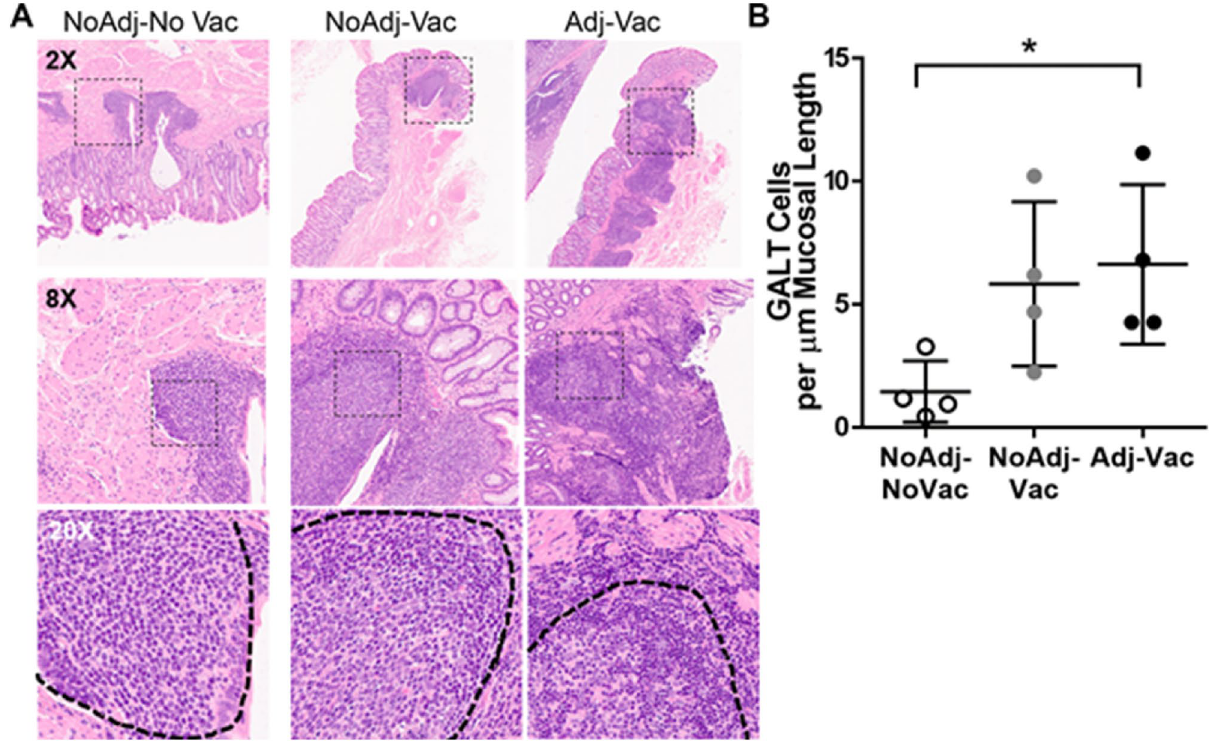
Figure 1. Increased lymphoid structures in rectoanal junction of vaccinated and challenged cattle. Histologic examination of recto-anal junction (RAJ) sections revealed increased gut-associated lymphoid tissue (GALT). Representative slides of RAJ collected from non-vaccinated (NoAdj-NoVac; left panels), non-adjuvanted-Δ hha E. coli -vaccinated (NoAdj-Vac) (middle panels) and oil-in water adjuvanted-Δ hha E. coli -vaccinated (Adj-Vac) (right panels) are shown ( A ). Panels increase in magnification from top (2 ×), middle (8 ×) and bottom (20 ×) panels. Hashed box indicates section of magnification shown in bottom panel. Dashed line in bottom row represents follicle boundary. ( B ) Quantification of GALT cells per um of mucosal length. Open circles represent NoAdj-NoVac, grey circles represent NoAdj-Vac, and black circles represent Adj-Vac. Three replicate tissue sections from each animal were analyzed and averaged for single data point for each animal. *p < 0.05 by one- way ANOVA with Tukey’s